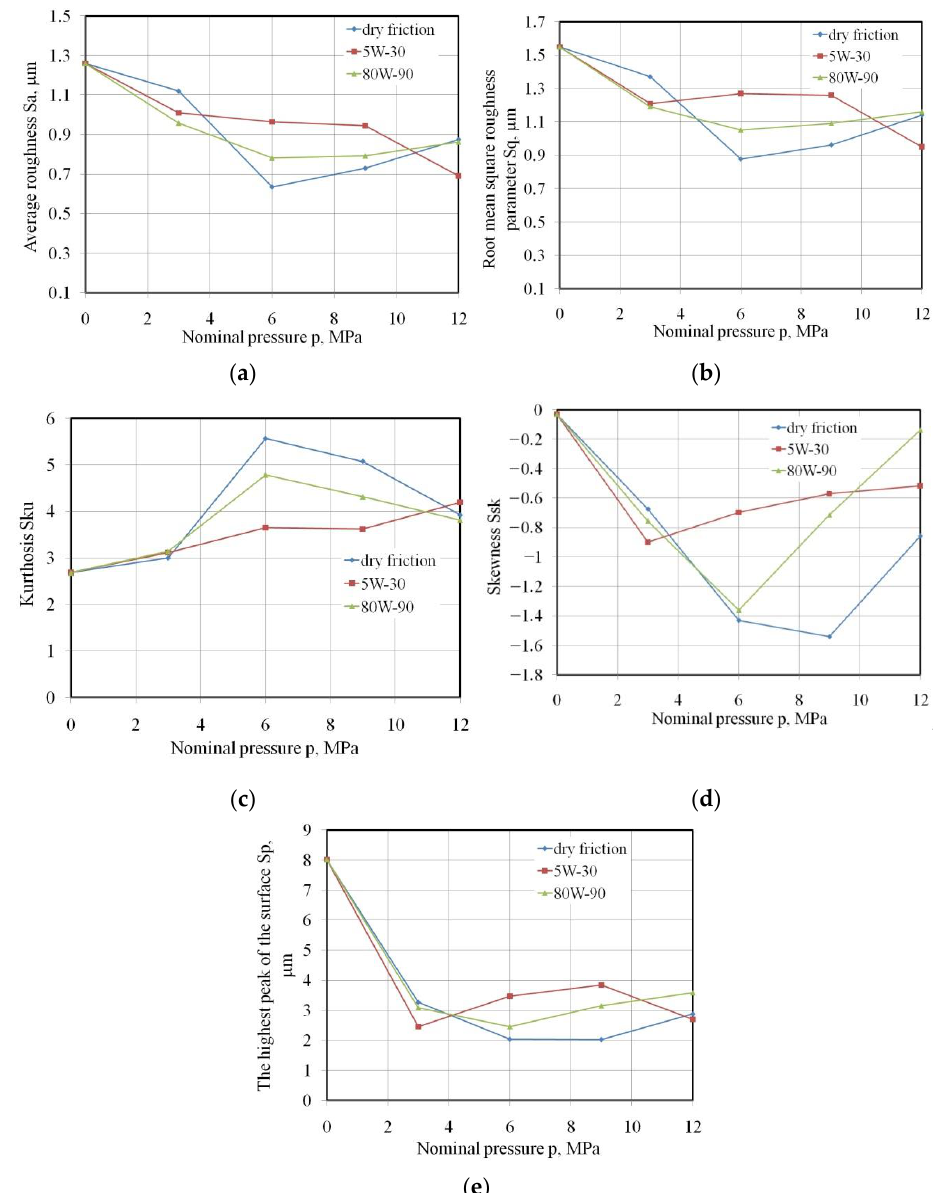
Figure 11. Effect of nominal pressure on variation of the ( a ) Sa, ( b ) Sq, ( c ) Sku, ( d ) Ssk, ( e ) Sp pa- rameters.